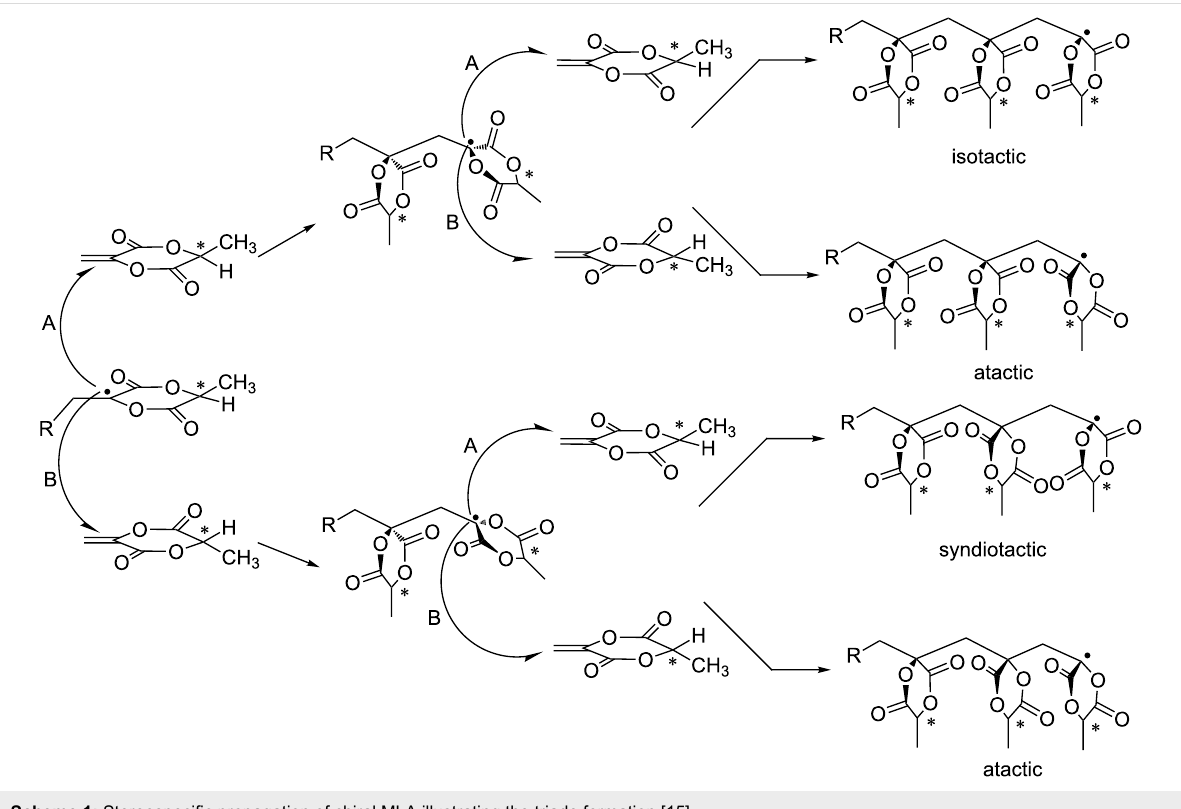
Scheme 1: Stereospecific propagation of chiral MLA illustrating the triade formation